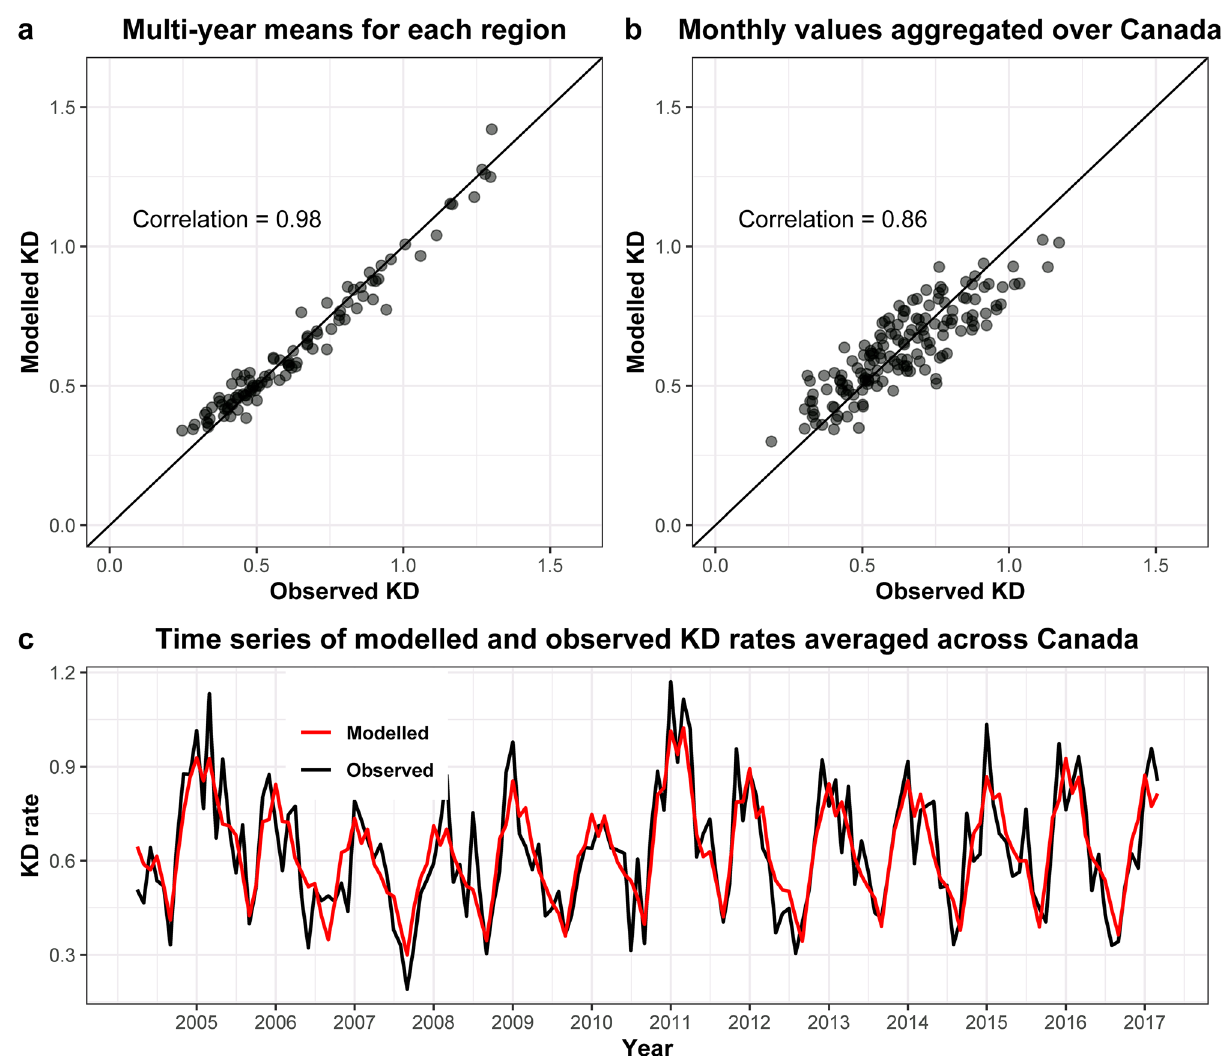
Figure 4. Correlation between observed and modelled Kawasaki disease (KD) rates. Modelled rates have been obtained from the exponentiated risk ratios of the multivariable hierarchical Bayesian model posteriors, multiplied by the expected rate. ( a ) Multi-year mean of observed and modelled KD rates, where each dot represents 1 of the 100 regions (groups of forward sorting areas). ( b ) Regional mean of observed and modelled KD rates. The rates were aggregated across all of Canada, and each dot represents 1 month of the 13 years. ( c ) Time series of observed (black) vs modelled (red) KD rates averaged over Canada from April 2004 to March